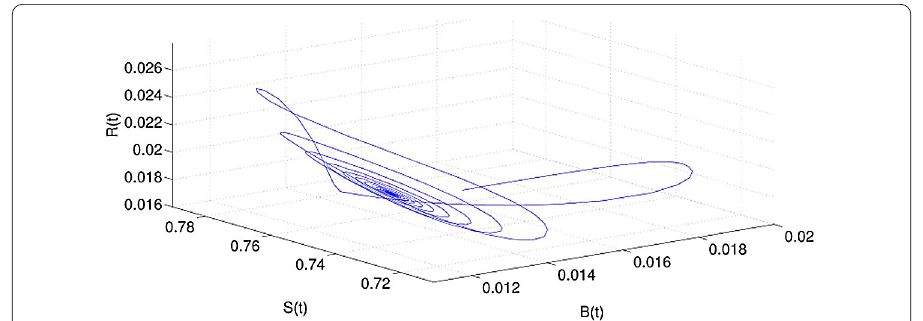
Figure 7 Dynamic behavior of system (41): projection on S-B-R with τ 2 = 42.5 ∈ (0, τ 20 ) and τ 1 = 0.8345